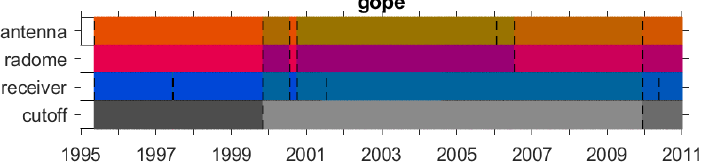
Figure 5. Schematic view of the equipment changes that occurred at station GOPE (Ondrejov, Czech Republic) during the period 1995–2010. Each color symbolizes a different equipment type (producer and product). Vertical dashed lines show additional changes with the same type (serial number or firmware upgrade in the case of receivers). Information extracted from the IGS site logs (ftp://igs.ign.fr/pub/igs/igscb/station/log/, accessed on 30 July